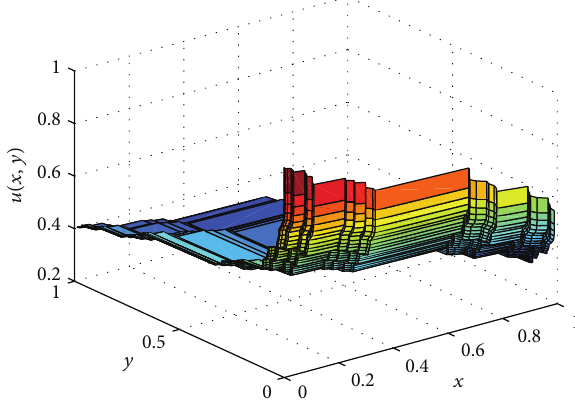
Figure 3: Plot of the nondifferentiable solution of (36) with the parameter 𝛼 = ln 2/ ln 3